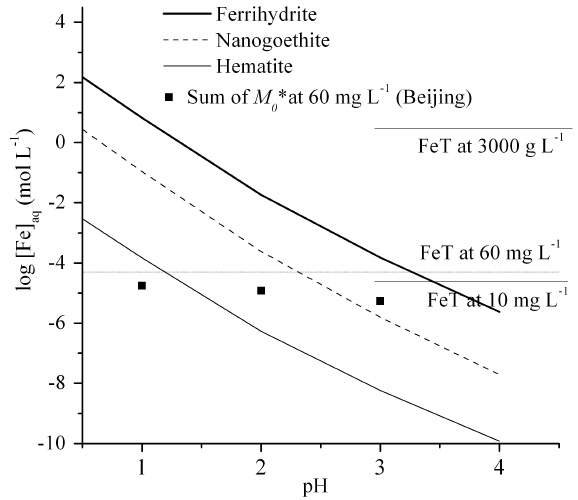
Fig. 7. Equilibrium Fe solubilities of a range of Fe(III) oxides between pH 0.5 and 4 versus the sum of M ∗ “fast”+“intermediate”+“slow” Fe pools) at 60mgL − 1 . Solubilities for the hematite were from Bonneville et al. (2009). Fresh ferrihy- drite and nanogoethite equilibrium Fe solubilities were experimen- tally measured at pH 3 and pH 2, respectively and further extrapo- lated to other pH values according to Bonneville et al. (2009). Hor- izontal solid lines represent the total Fe concentrations (µmolL − 1 ) , if all of FeT in Beijing dust was solubilised for various dust/liquid ratios (10 and 60mgL − 1 , and 3000gL − 1 ) . Note that M ∗ recalculated from M 0 (Table 2) assuming an experimental concen- tration of 60mgL − 1